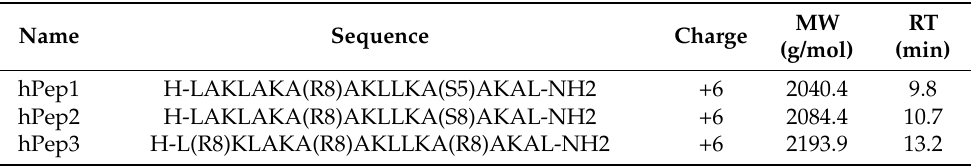
Table 1. The structures and properties of the peptides used in the